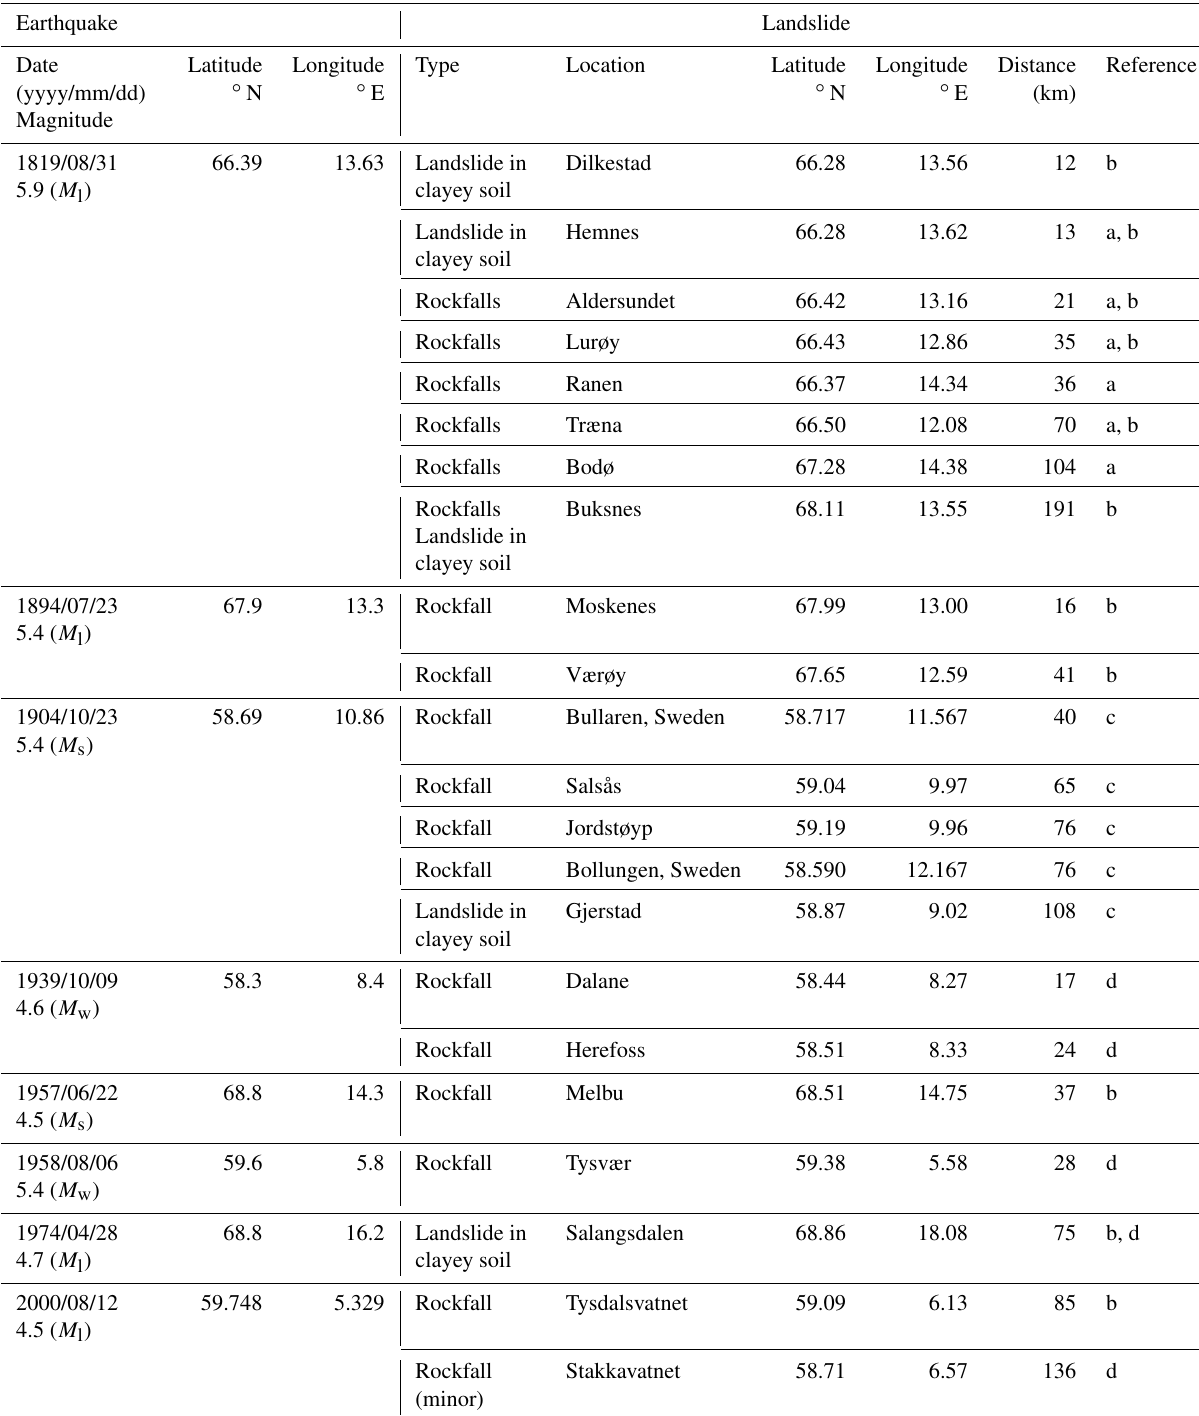
Table 1. Earthquake-induced landslides in Norway identified in this study. Magnitudes are local magnitude ( M l ), surface wave magnitude ( M s ) or moment magnitude ( M w